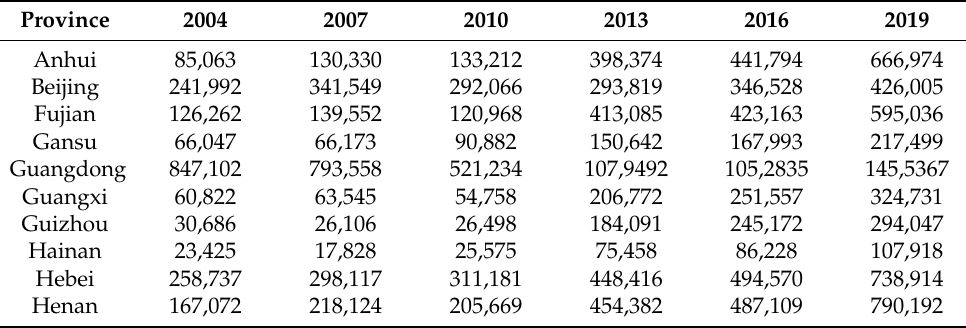
Figure 3. Calculated EG in 2004 ( left ) and 2019 ( right ) for 30 Chinese provinces, autonomous regions, and municipalities. Table 3. NTL data value of sample province from 2004 to 2019 (Unit: DN).